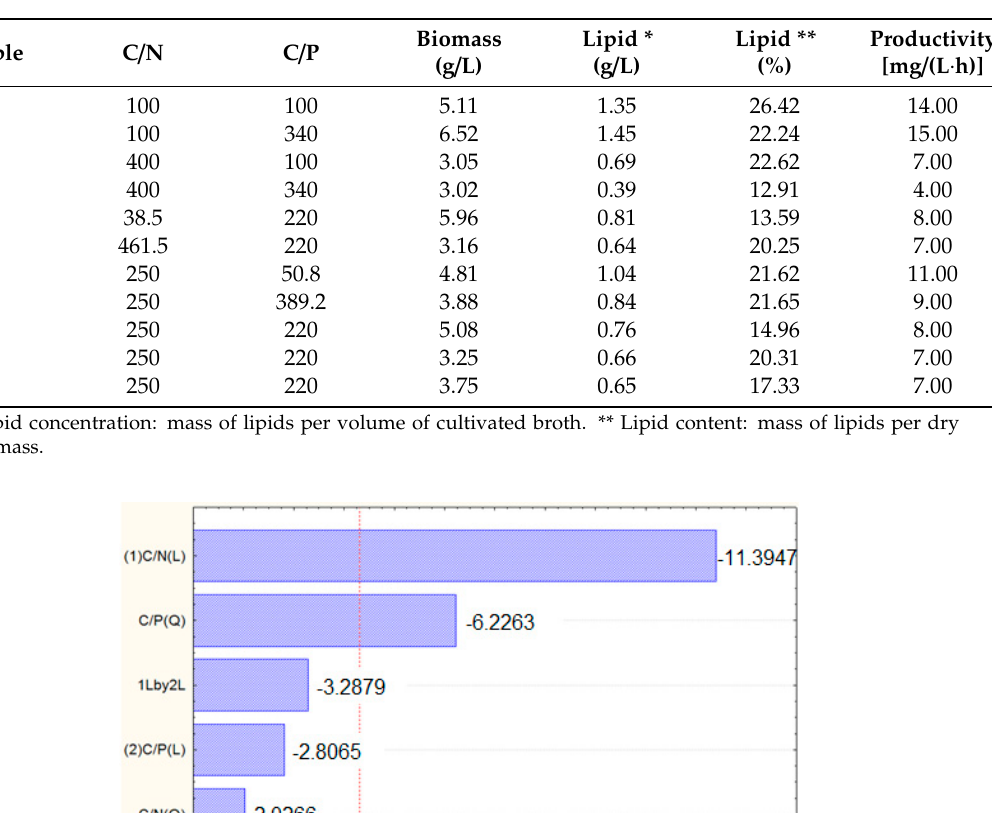
Table 5. Results for biomass and lipid production by R. toruloides after 96 h of cultivation in EHH at different C/N and C/P ratios.